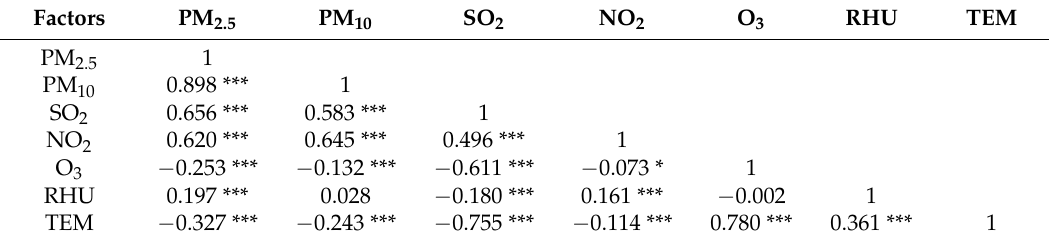
Table 2. The coefficient of spearman rank correlation between air pollutants and meteorological factors in Taiyuan, China. Factors PM 2.5 PM 10 SO 2 NO 2 O 3 RHU